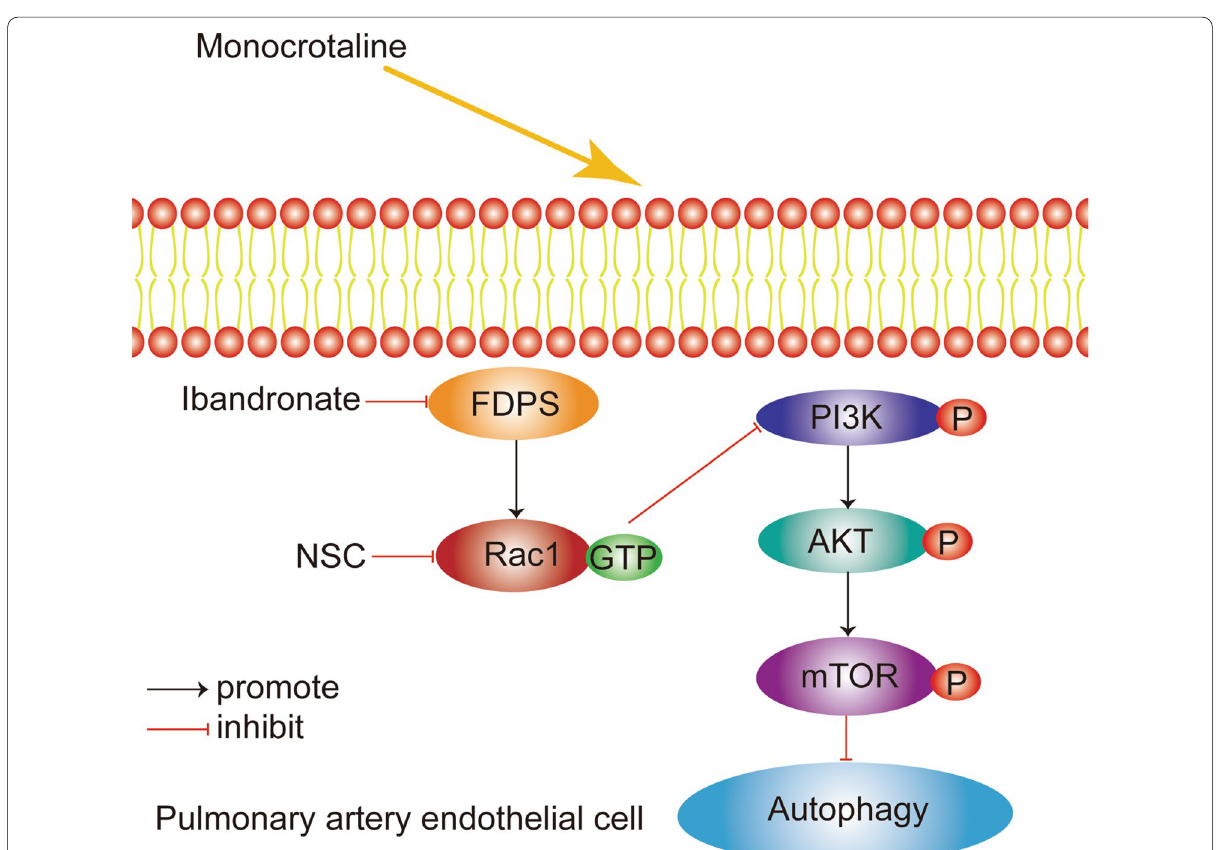
Fig. 6 Illustration of the role of FDPS on autophagy in PAECs upon PAH. FDPS expression is up-regulated in pulmonary artery after MCT treatment, which consequently leads to an increase of PAECs autophagy level through the PI3K/AKT/mTOR pathway. Additionally, FDPS may also increase activation of Rac1. Inhibition of FDPS or Rac1 reduces PAECs autophagy and